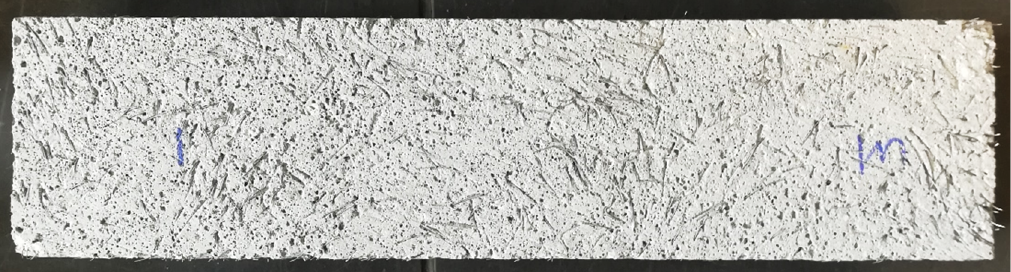
Figure 7. Flexural and compressive strength of specimen without and with micro steelfibers (cut out 0°/90° to printing direction).